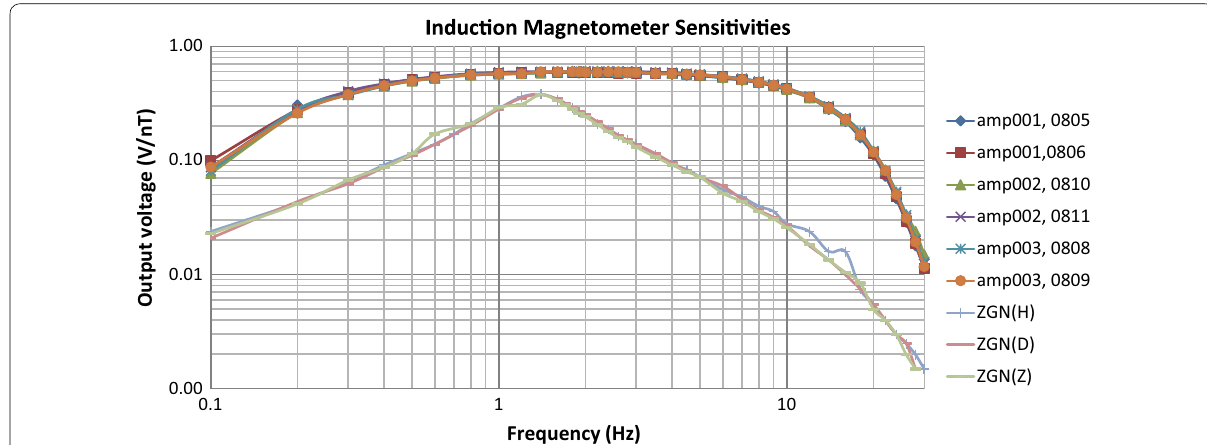
Fig. 7 Frequency dependence of sensitivities of the induction magnetometers